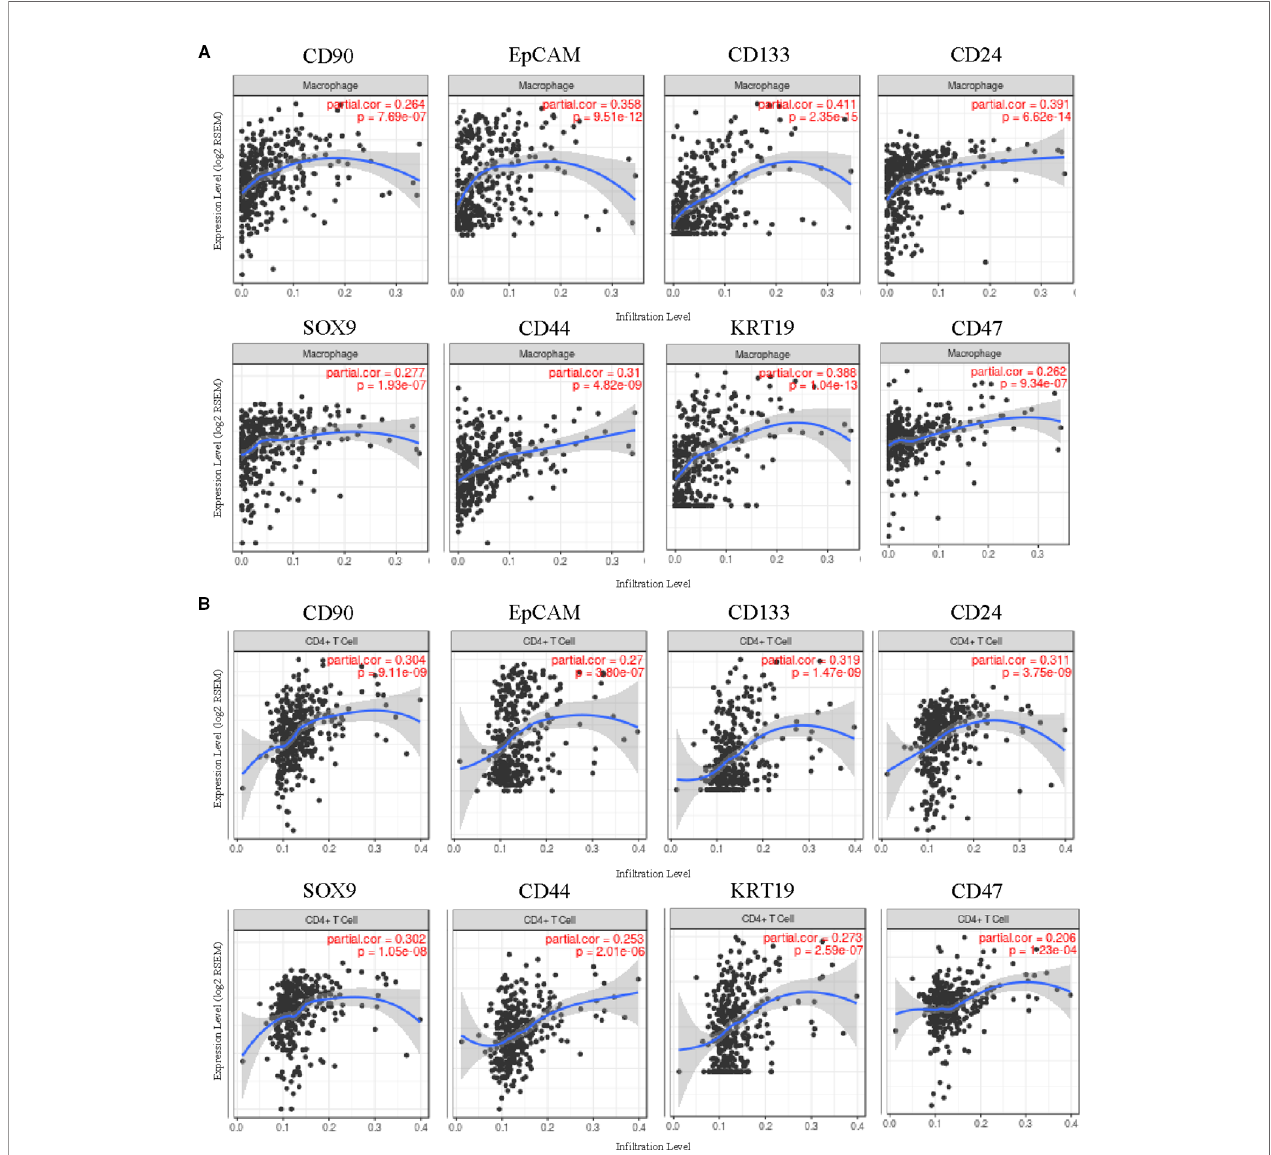
FIGURE 4 | Correlation of seven HCSC markers expression with immune in fi ltration level in